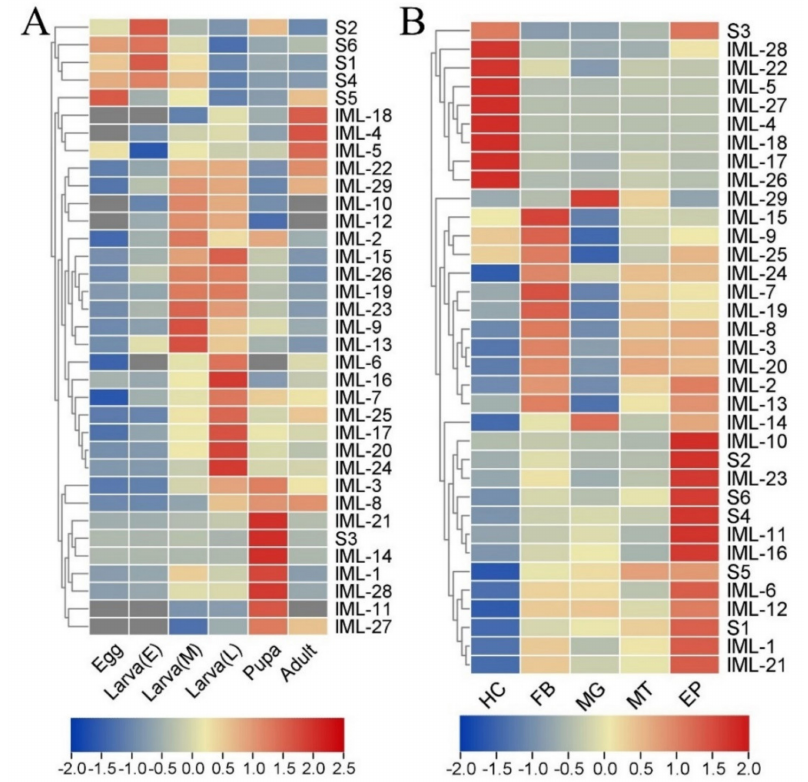
Figure 7. Temporal and spatial expression patterns of M. separata CTLs: ( A ) the expression profile of 35 CTLs in eggs, early stage larvae (E), mid-stage larvae (M), late-stage larvae (L), pupa, and adults; ( B ) the expression profile of 35 CTLs in larval tissues. HC, hemocytes; FB, fat body; MG, midgut; MT, Malpighian tube; EP, epidermis. Values (log2) representing the relative expression levels were normalized for each gene (row) and mapped to the color scale on the bottom. Dendrograms were generated by the hierarchical clustering analysis of rows. Genes displaying similar expression patterns were recursively merged into